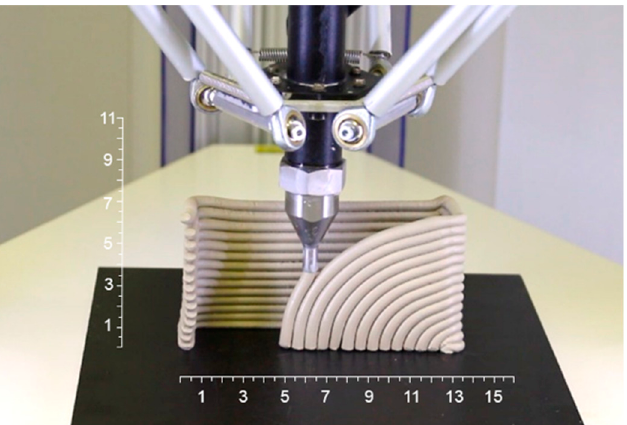
Figure 7. Generation of arc geometry I (Table 8) with complex path instruction (material extrusion + tool) as ‘non-horizontal layering’ in the LDM of clay. Table 7. Illustration of path instructions of arc geometry I in the material extrusion path and tool path or movement.